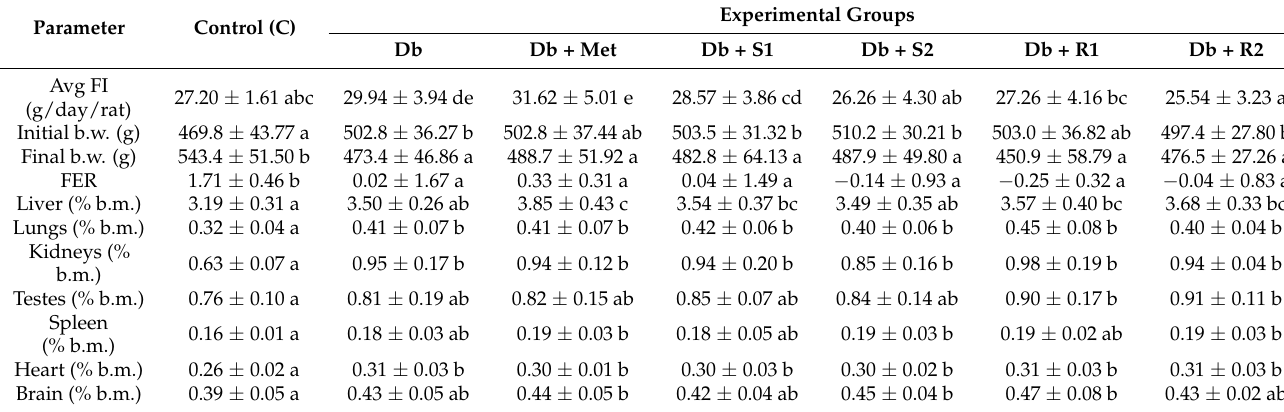
Table 1. Effect of diet and supplementary steviol glycosides (SGs) on overall growth indices and relative organ mass in rats. Experimental Groups Parameter Control (C) Db